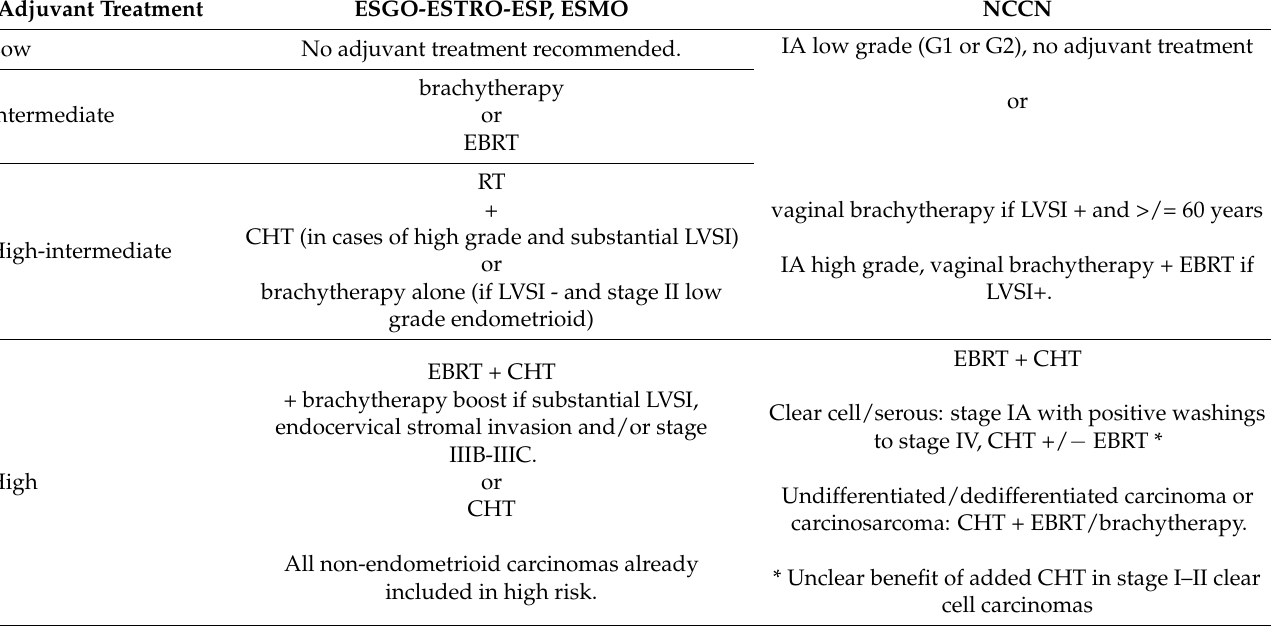
Table 2. Adjuvant treatment stratified on risk